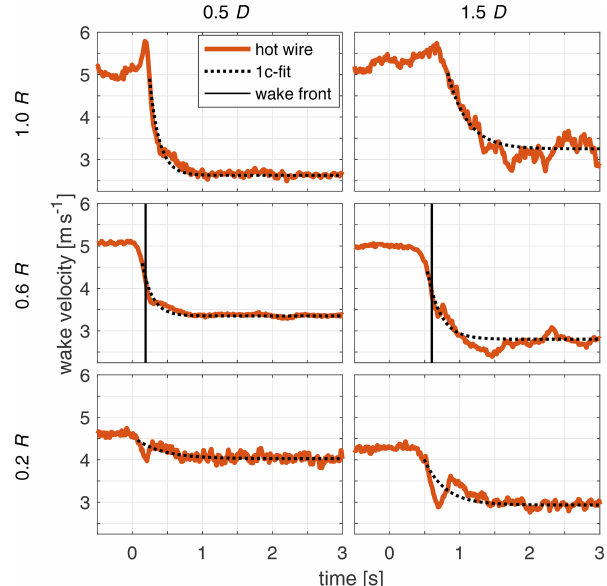
Figure 17. Ensemble averages of the axial wake velocity measured by hot wires for the three radii of 0.2, 0.6 and 1 R at 0.5 and 1.5 D distances behind the turbine for the step to high load.